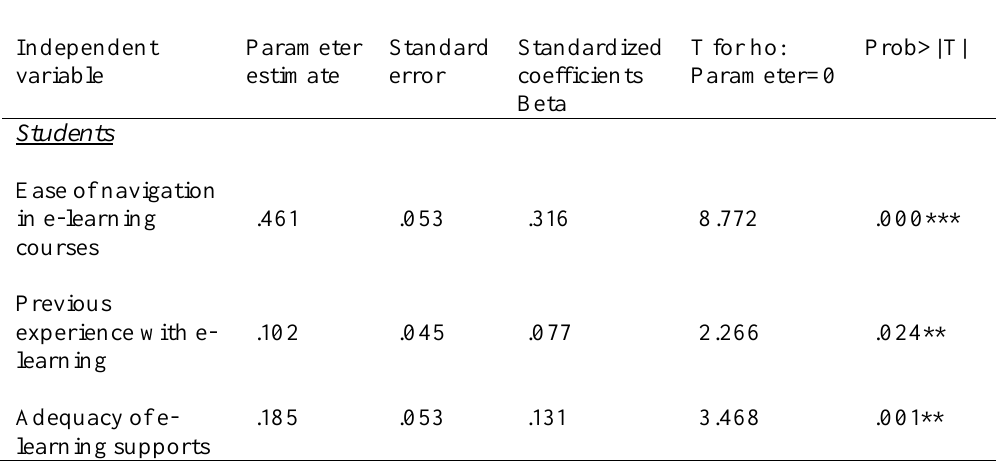
Regression Analysis – Dependent Variable: Preference for E-Learning over Traditional Formats